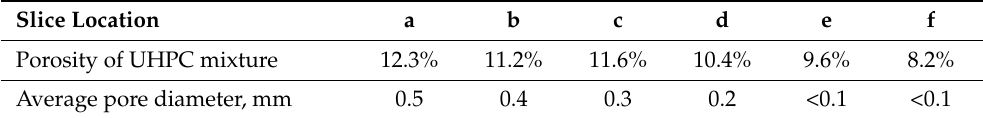
Table 4. Porosity of 6 wt.% straight BCSF-reinforced UHPC mixtures from the top to the bottom cured for 28 days.